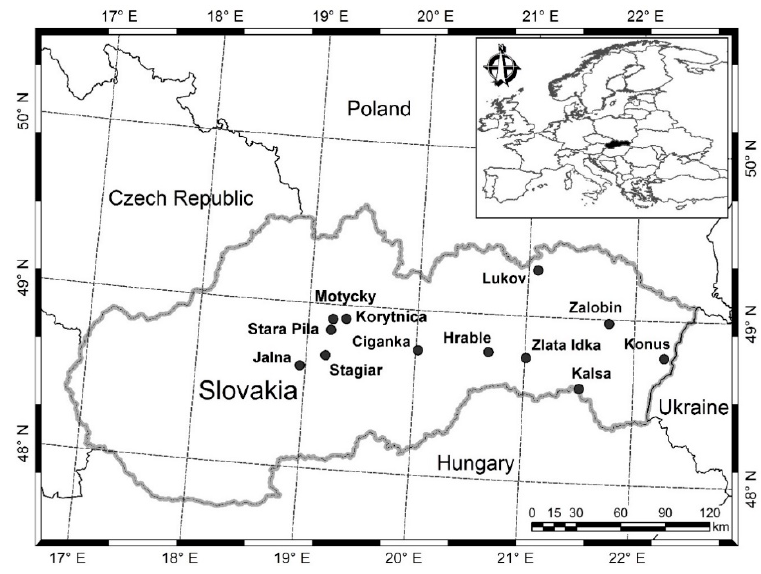
Figure 1. Location of long-term research plots.